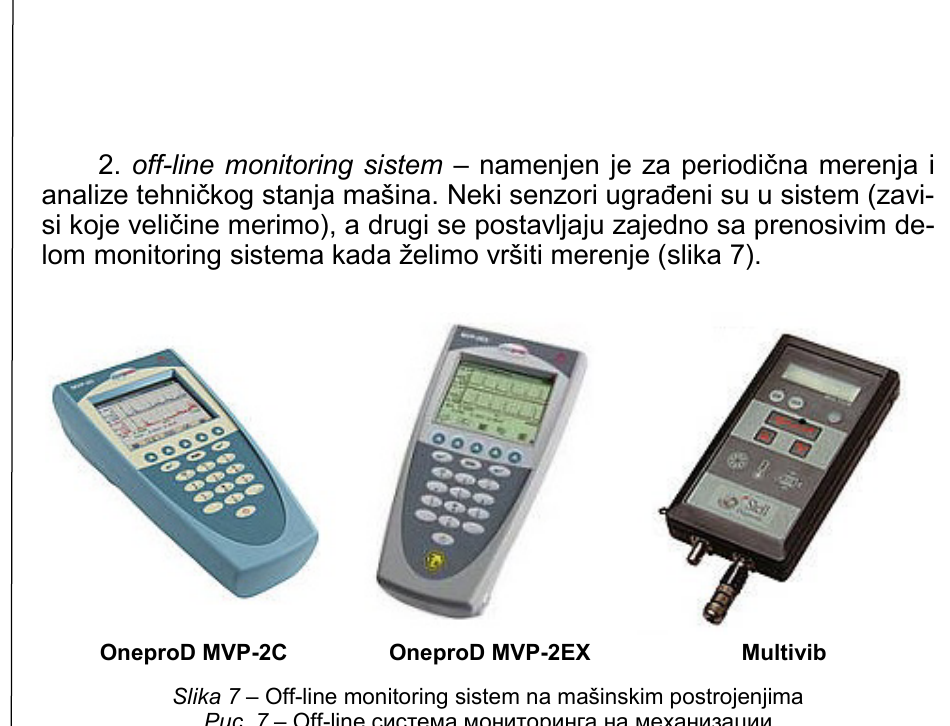
Figure 7 – Off-line monitoring system on mechanical